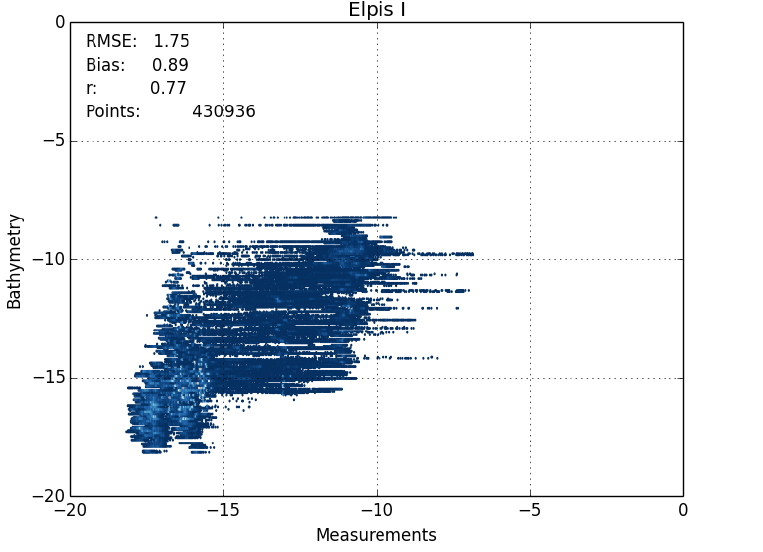
Figure 9: Density scatter plot comparing sonar bathymetry (x-axis) and satellite bathymetry (y-axis) over the Elphis I wreck. Brighter colours indicate higher density of points, darker colours lower